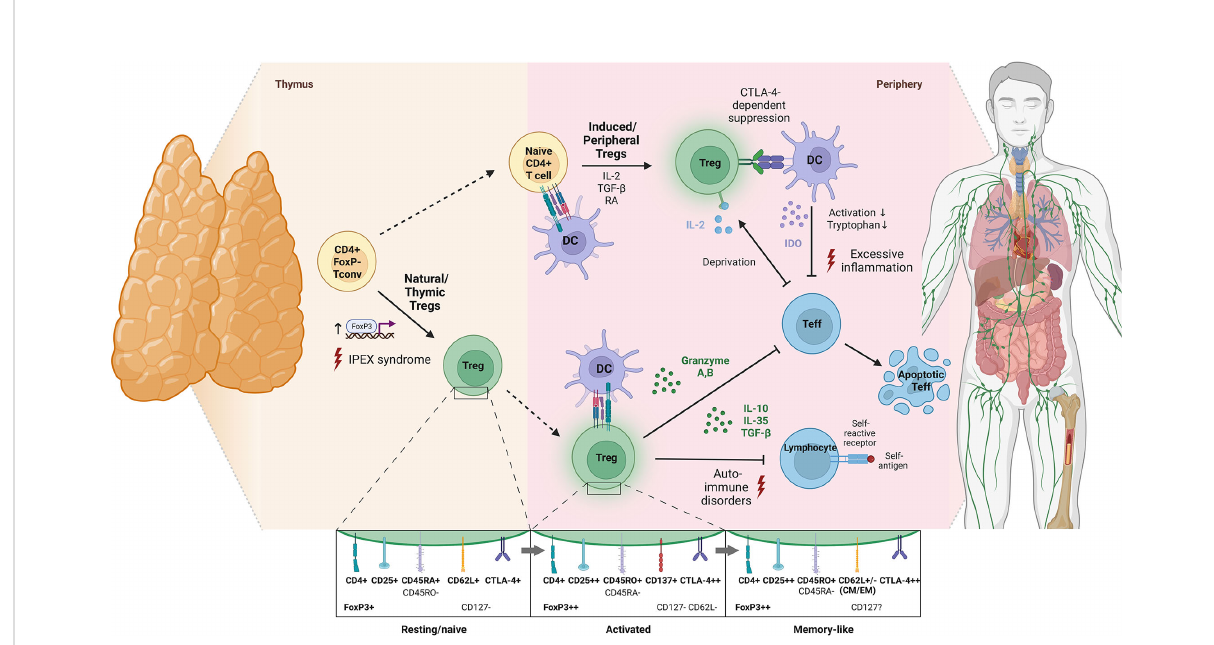
FIGURE 1 Schematic illustration of Treg development, modes of activation and physiological functions. According to an af fi nity-based model of T cell development, a fraction of self-reactive T cells with intermediate af fi nity for self-peptide-MHC complexes differentiates into natural Tregs by upregulation of FoxP3 and CD25 in response to T cell receptor (TCR) signaling (thymus-derived Tregs; ~80% of peripheral Treg repertoire) (31). Also, antigenic stimulation of peripheral naïve T cells in the presence of TGF- b , IL-2 and retinoic acid induces their differentiation into FoxP3+ Tregs (peripherally-derived Tregs) (28). Of note, phenotypical transition of Tregs upon activation is not associated with de novo expression of surface proteins but rather with quantitative shifts in the expression levels of molecules already expressed in a resting state. Speci fi cally, upon TCR activation, Tregs downregulate CD45RA and upregulate CD45RO, CD25, CTLA-4 and FoxP3 (32, 33). In contrast to other T cell subsets, the transition of Tregs into a stable memory pool after antigen elimination is still debated and so far, only a few marker candidates such as CD62L have been proposed for identi fi cation of memory Tregs (34). Functionally, Tregs are involved in suppressing immune responses towards self and non-self-antigens via inhibitory cytokine secretion, granzyme-dependent and cytokine-deprivation-mediated effector cell inhibition as well as cell-contact-dependent alteration of dendritic cell function and maturation (potential consequences of de fi cient Treg development or function are indicated by red lightnings) (35) (created with BioRender.com). CM, central memory; CTLA-4, cytotoxic T lymphocyte antigen 4; DC, dendritic cell; EM, effector memory; IDO, indoleamine 2,3-dioxygenase; IPEX, Immunodysregulation, polyendocrinopathy, enteropathy, X-linked syndrome; RA, retinoic acid